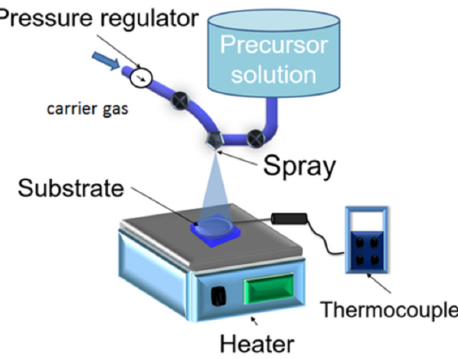
Figure 1. Experimental setup employed to grow oxide thin films at low molarity condi ‐ tions.